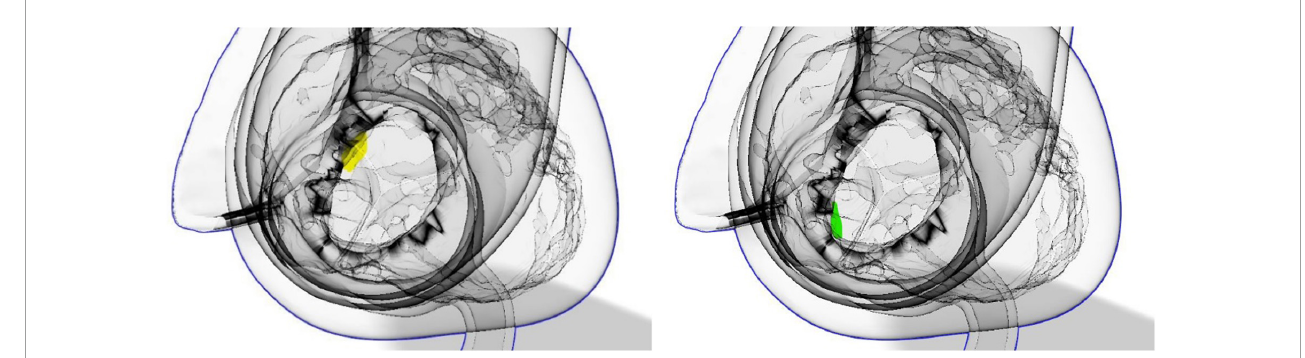
FIGURE9 Location of PVLs in the case of continuous retrograde flow (left) and in the case of pulsatile flow (right) highlighted in yellow.